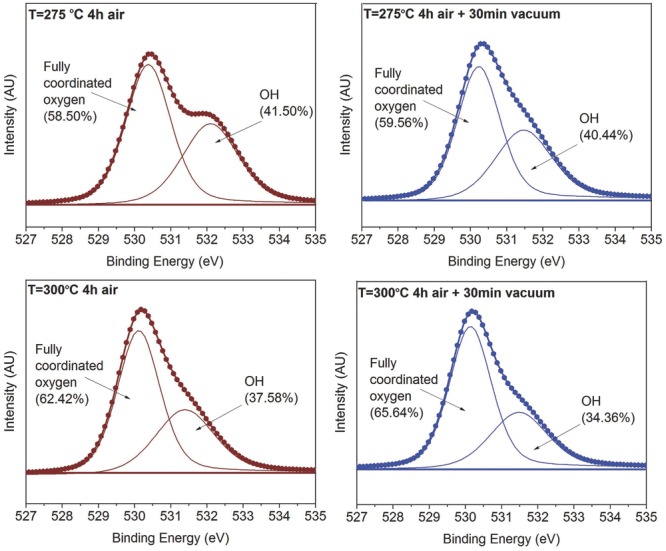
XPS O1s peak for samples annealed at different temperatures
in air with and without an additional vacuum annealing step
(In2O3:ZnO = 6:4): Left: 4 h air anneal
only; Right: 30 min additional vacuum annealing; Top: 275 °C; Bottom:
300 °C. We can distinguish two oxygen binding environments: 1) OH
species at ≈532 eV; and 2) fully coordinated oxygen at ≈530
eV.